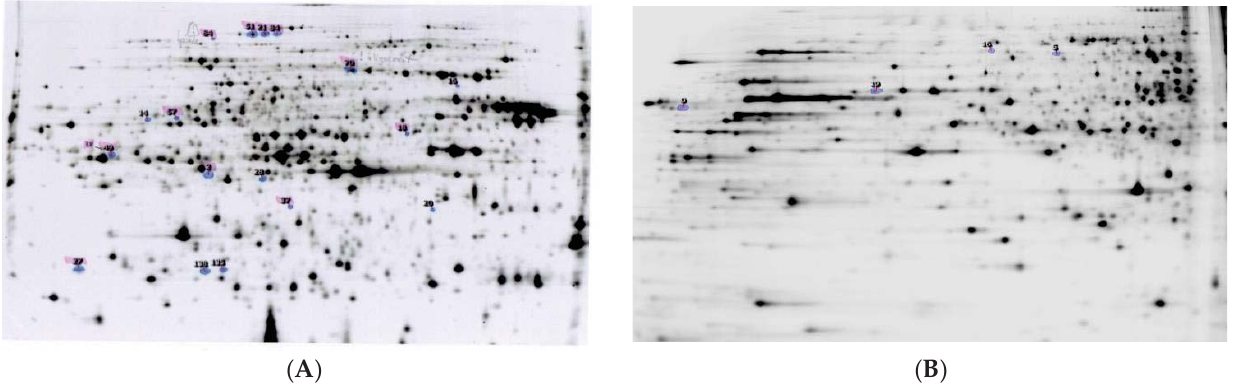
Figure 2. Proteomic profiles showing protein abundance between control and DMSO-treated brain groups. ( A ). Bidimen- sional gel electrophoresis separation of the brain of Agrotis ipsilon showing about 1292 protein spots after a pre-migration in the pH range 5–8 (Colloidal Coomassie Blue G250). ( B ). Bidimensional gel electrophoresis separation of the brain of Agrotis ipsilon showing about 468 protein spots after a pre-migration in the pH range 6–9 (Colloidal Coomassie Blue G250). Numbers and colored spots were defined by the software in order to visually identify and number the spots presenting a difference in protein quantity between two